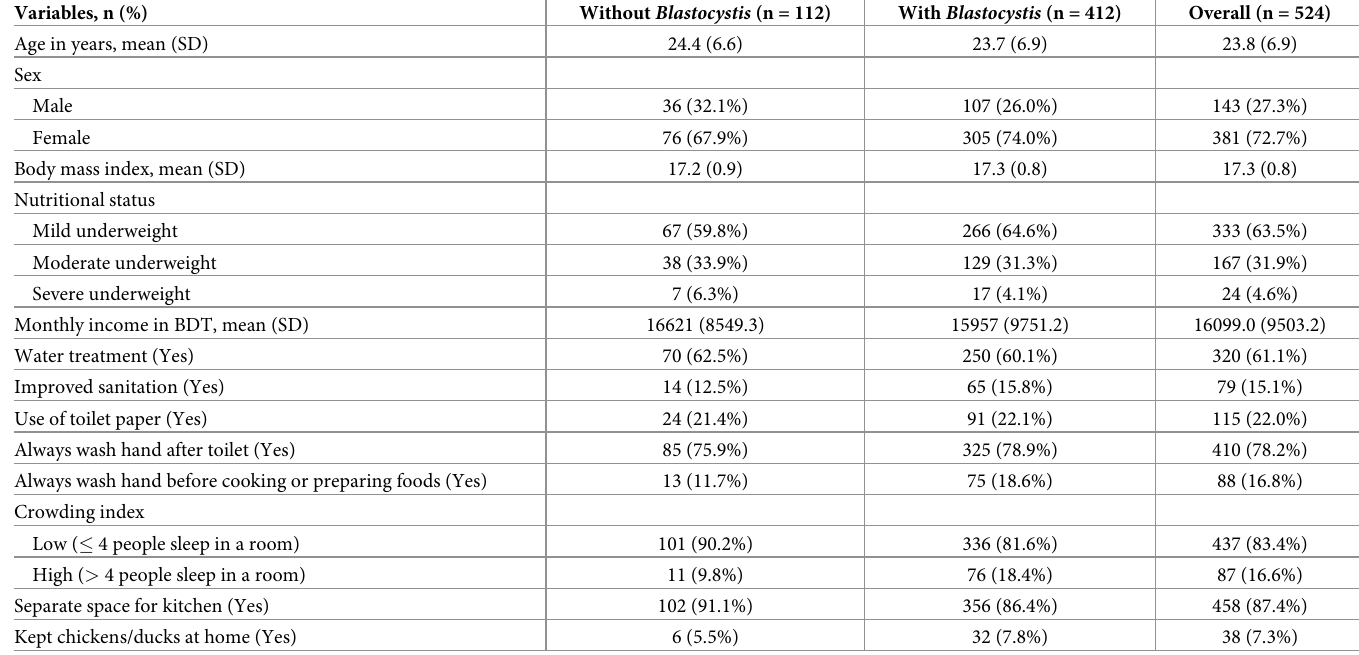
Table 1. Descriptive characteristics of the study